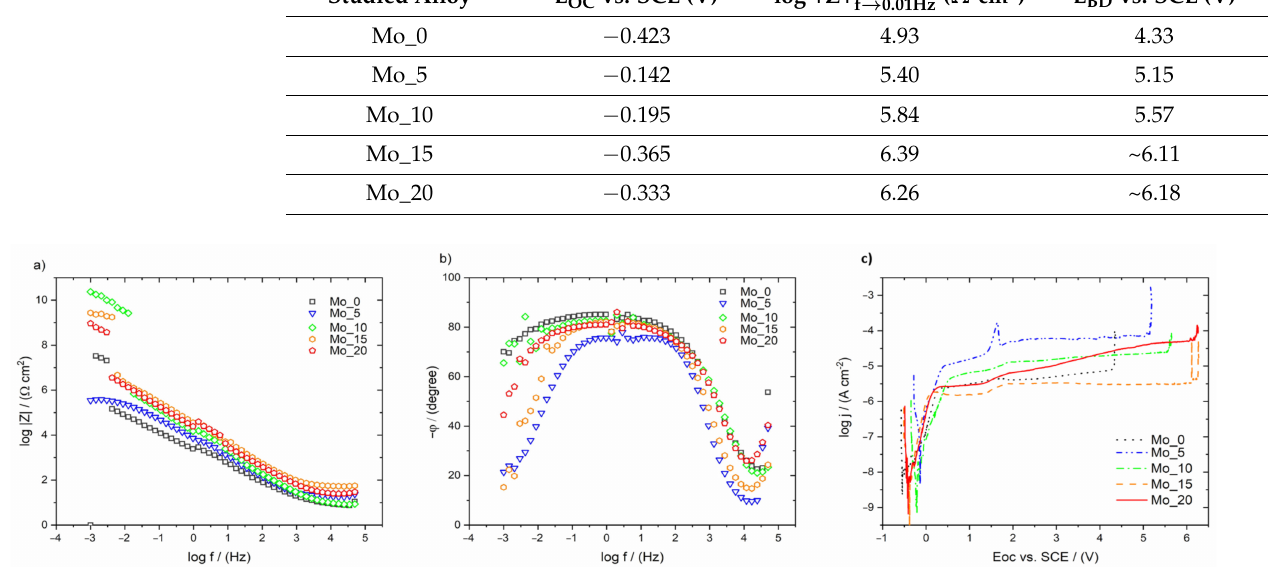
Figure 6. Bode diagram registered at E OC ( a ) log |Z| = f(log f) and ( b ) ϕ = f(log f), and ( c ) anodic polarization curves for HEA electrodes exposed in Ringer’s solution at 37 ◦